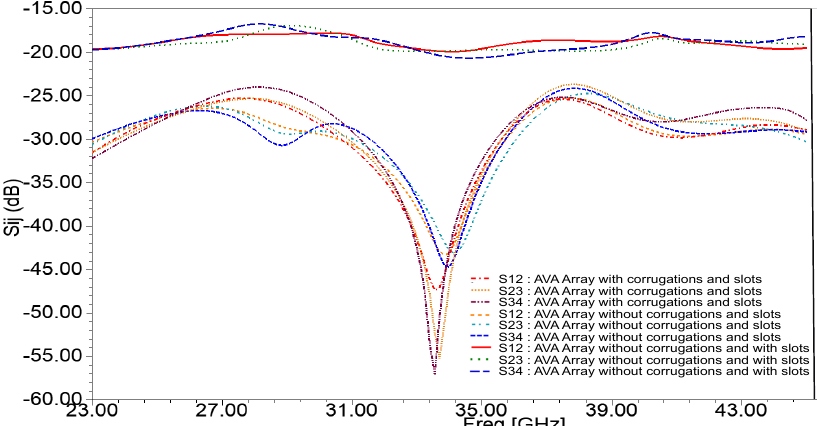
Figure 8. Simulated mutual coupling between array elements after removal of 1 × 4 power